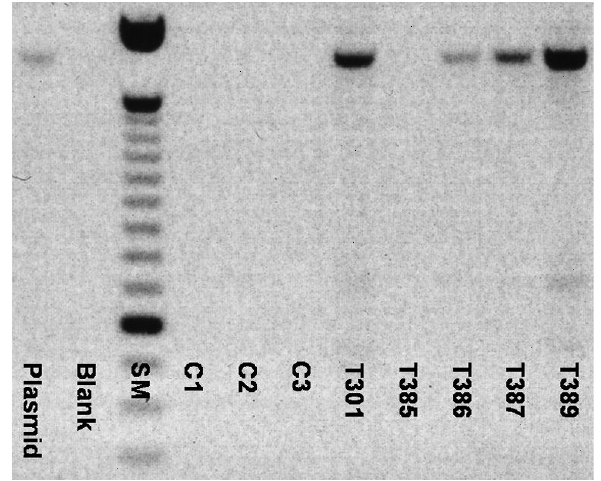
Figure 2 - Detection of Nag70 mRNA transcripts by RT-PCR. SM (size marker) – 100 bp DNA ladder, Blank – H 2 O sample, C1 – non-transgenic Pinova, C2 and C3 – non-transgenic plants of two other apple cultivars, T301-T389 – Nag+Endo transgenic lines of the apple cultivar Pinova.